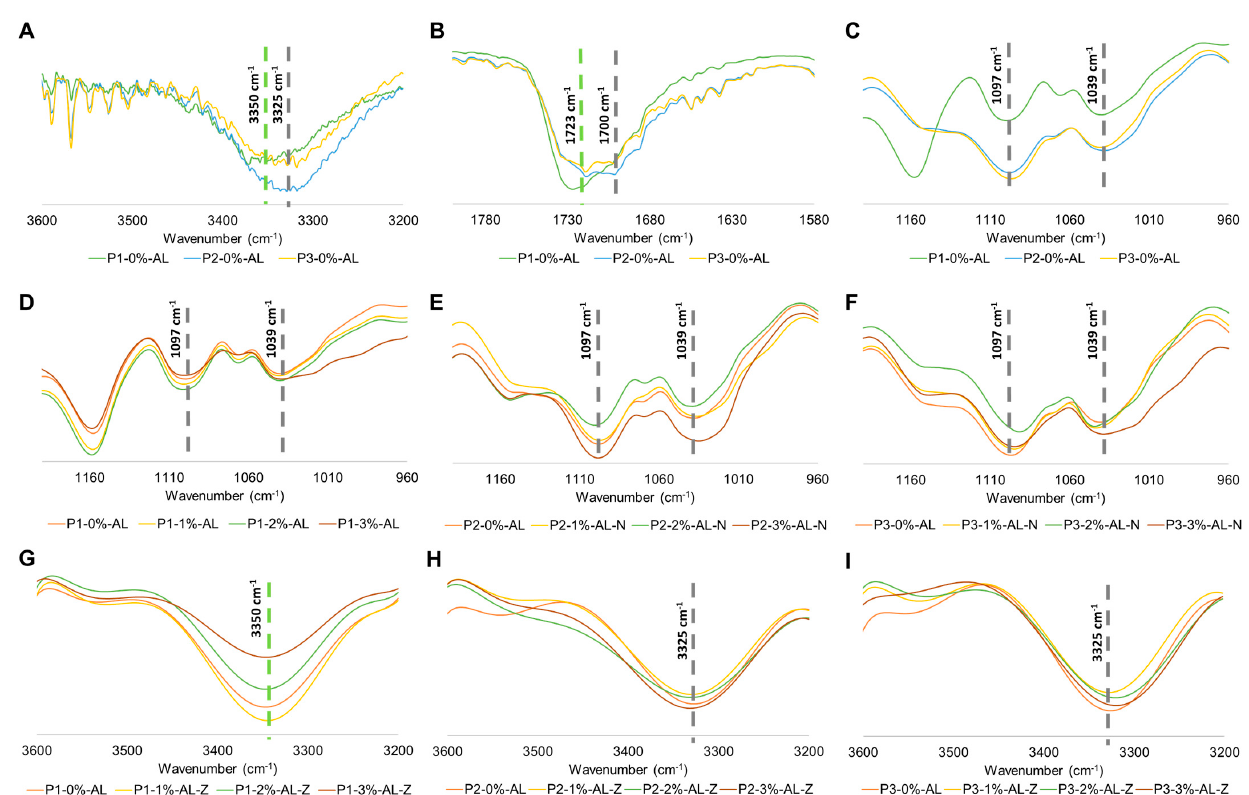
Figure 3. FTIR characterization of PU-starch composites. PUs matrices without filler in ( A ) the N-H region ( B ) C=O region ( C ) C-O-C region. ( D – F ) PU matrices with AL-N filler in C-O-C region. ( G – I ) PU matrices with AL-Z filler in N-H region.